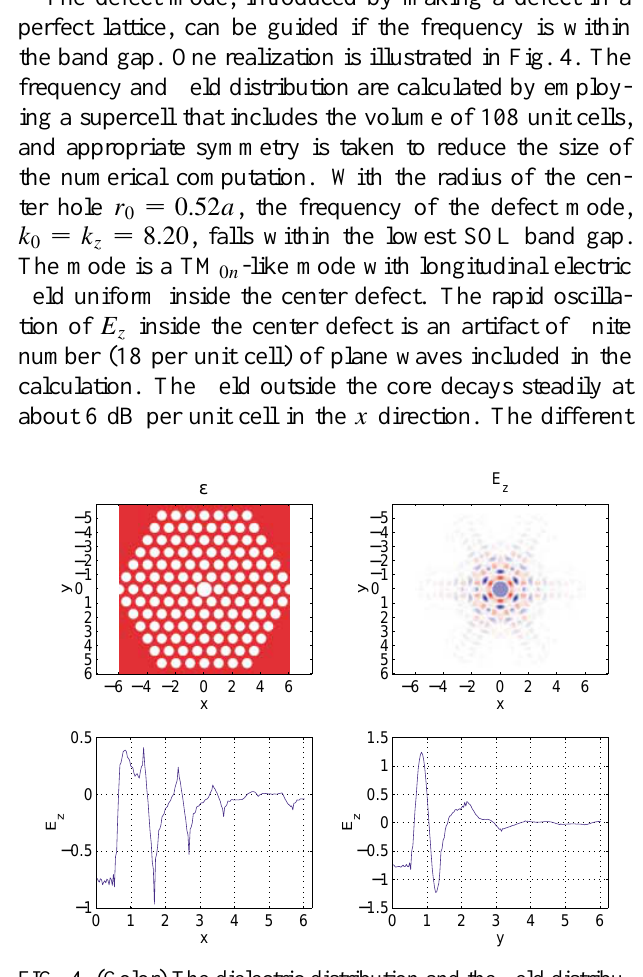
FIG. 4. (Color) The dielectric distribution and the field distribu- tion of the defect mode trapped by 2D PBG fiber. In the top right plot, blue and red represent negative and positive values, respectively.